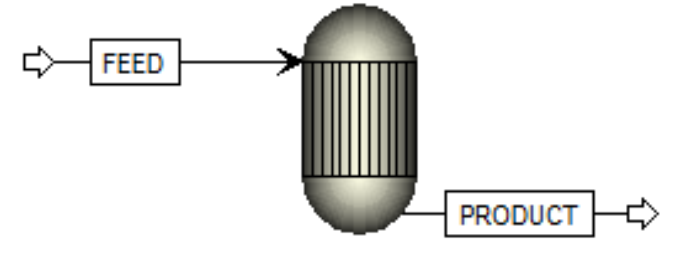
Figure 1. Equilibrium reactor for methanol production in Aspen Plus environmental. Table 1. Material and energy balances of methanol reactor obtained in Aspen Plus environmental. Factor